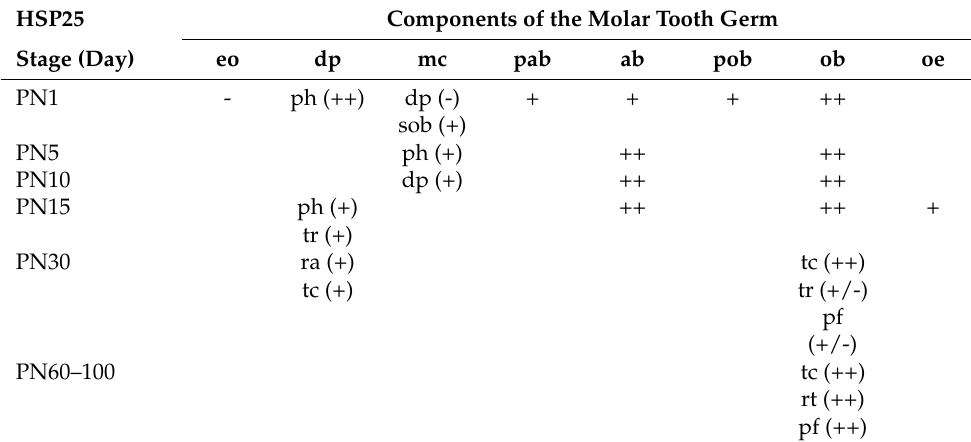
Table 2. Expression of heat shock protein 25 (HSP25) in the mandibular first molar on postnatal (PN) day 1–100 in rats. HSP25 Components of the Molar Tooth